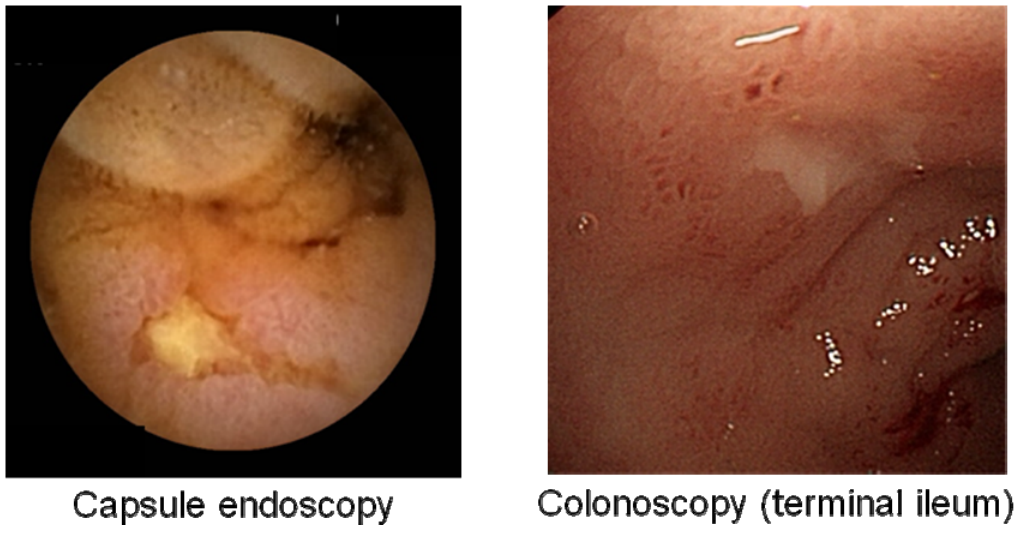
Figure 2. ASA-Induced small intestinal mucosal breaks (ulcers).